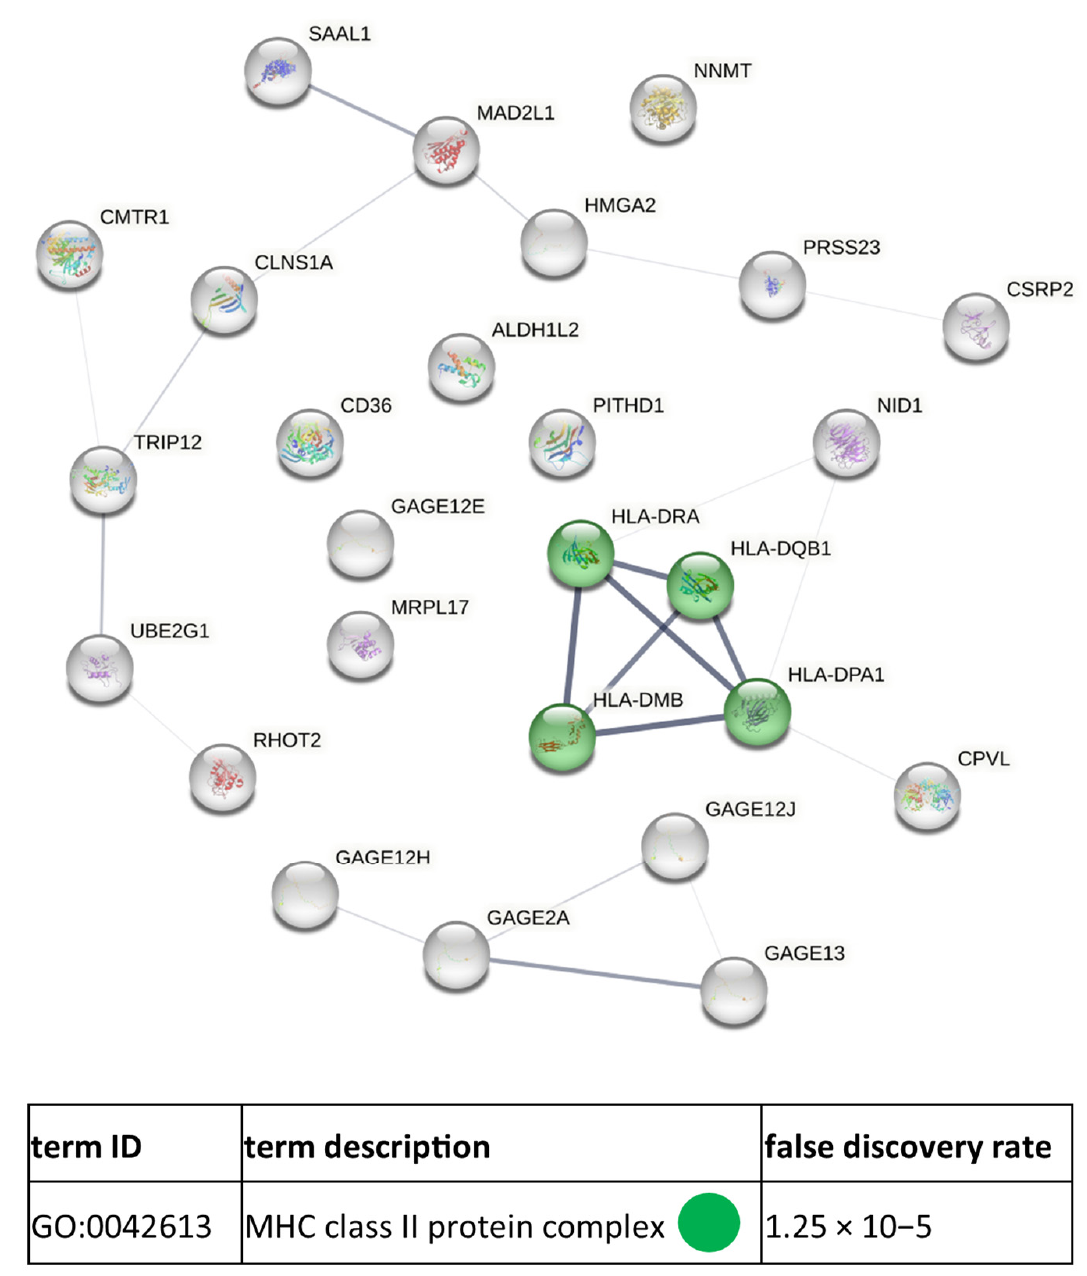
Figure A4. Diagram of functional protein association networks prepared with the use of STRING v. 11.0 software for proteins identified in WM115 cells but not found in any replicates of WM266-4 cells. The selected, strongly represented pathways are presented as an interactome. A complete analysis is presented in Supplementary Data S3.